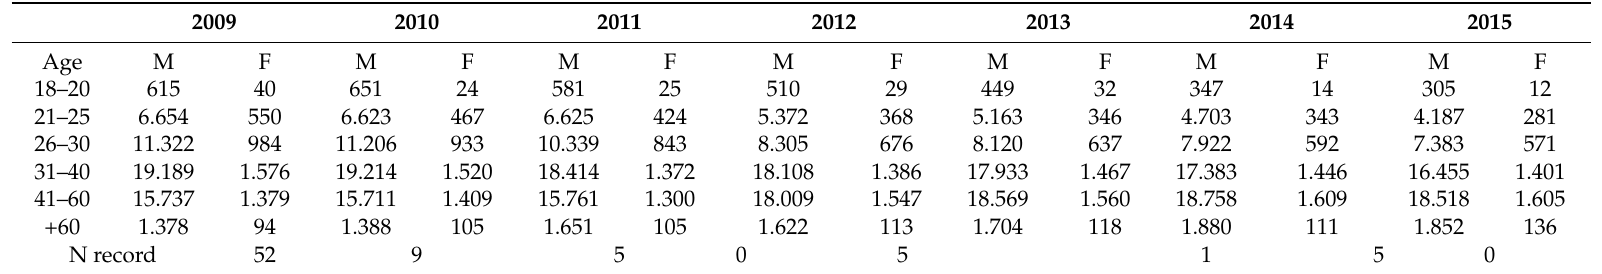
Table 3. Prison inmate population by age group and